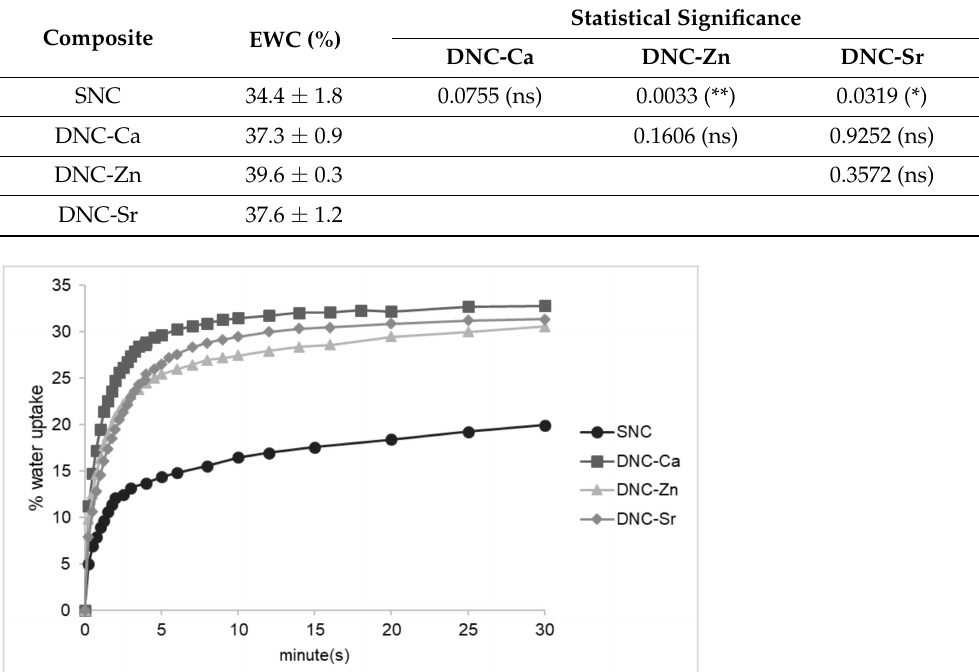
Figure 3. Water uptake of dual network composites chelated with Ca 2+ (DNC-Ca), Zn 2+ (DNC-Zn) and Sr 2+ (DNC-Sr) compared to the single network composite (SNC) at initial period in deionised water at 37 ◦ C.